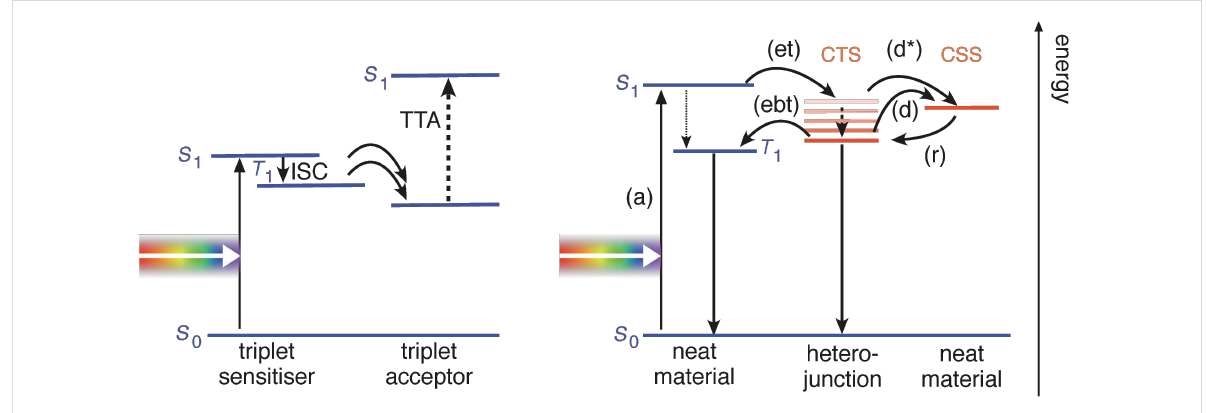
Figure 1: Spin dependent processes in organic solar cells. (Right) The steps from light absorption (a) towards generation of free charge carriers (d), potentially supported by (Left) triplet–triplet annihilation (TTA), are described in the text. Only the lowest excited states of each kind are shown for